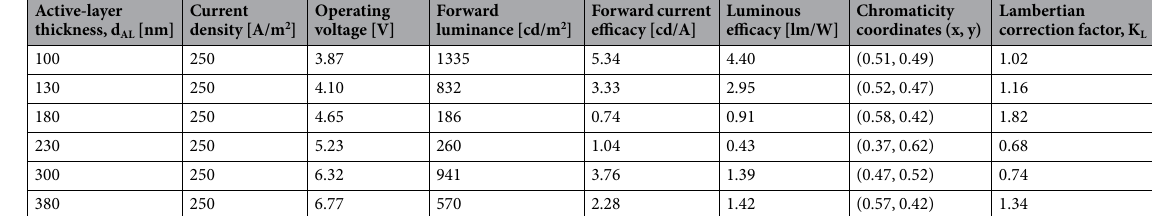
Table 1. Steady-state optoelectronic performance data of LECs with different active-layer thicknesses. The Lambertian correction factor, K L , is defined in Equation